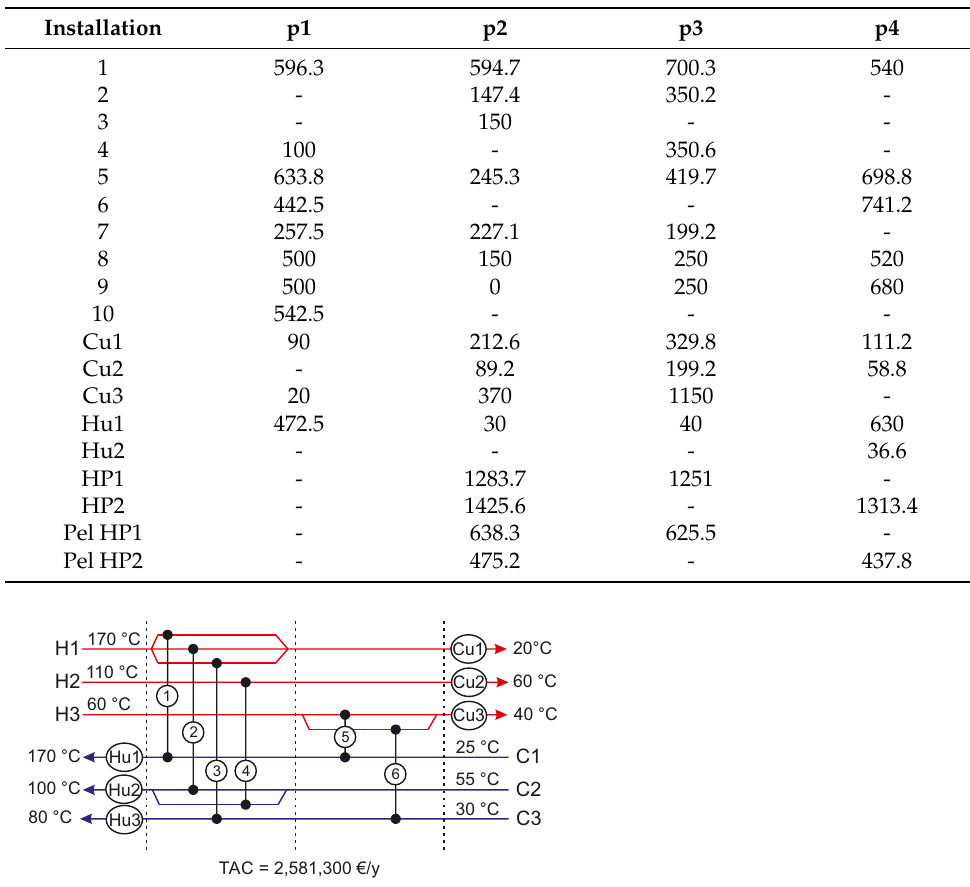
Figure 4. HEN obtained without HP and ST options case